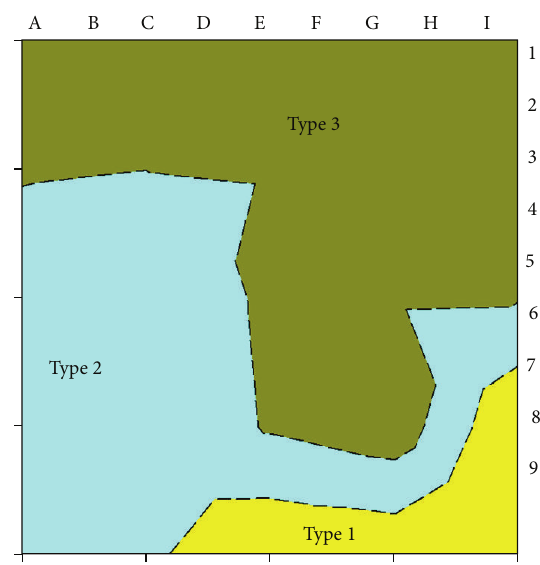
Figure 10: A contour plot of three areas of different